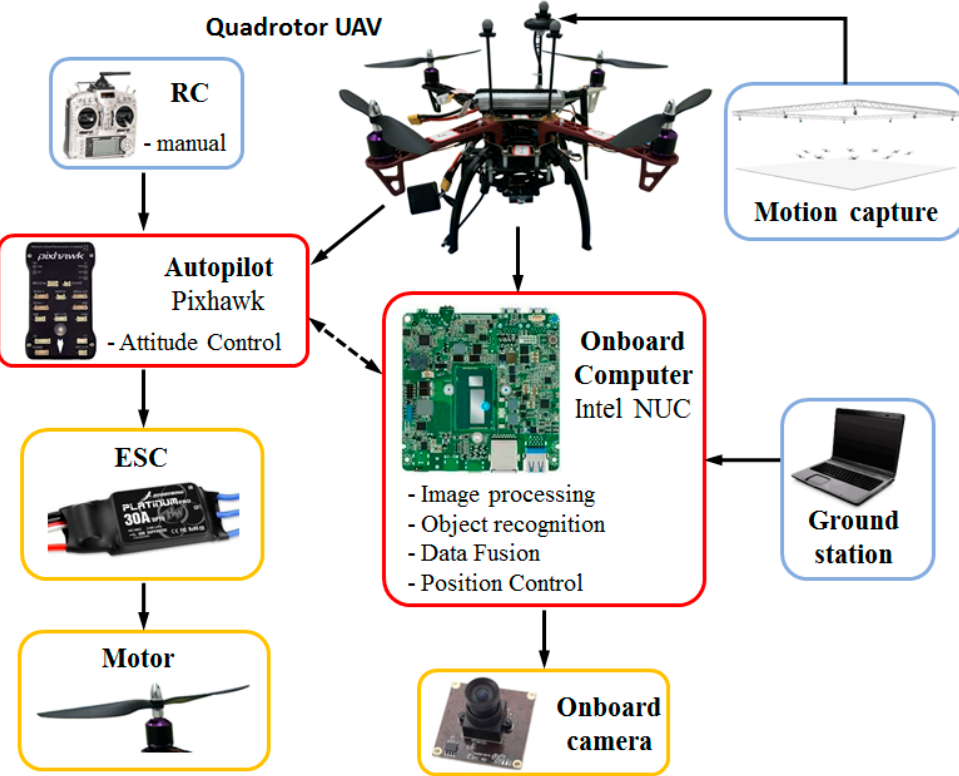
Figure 9. The architecture of the experimental system.